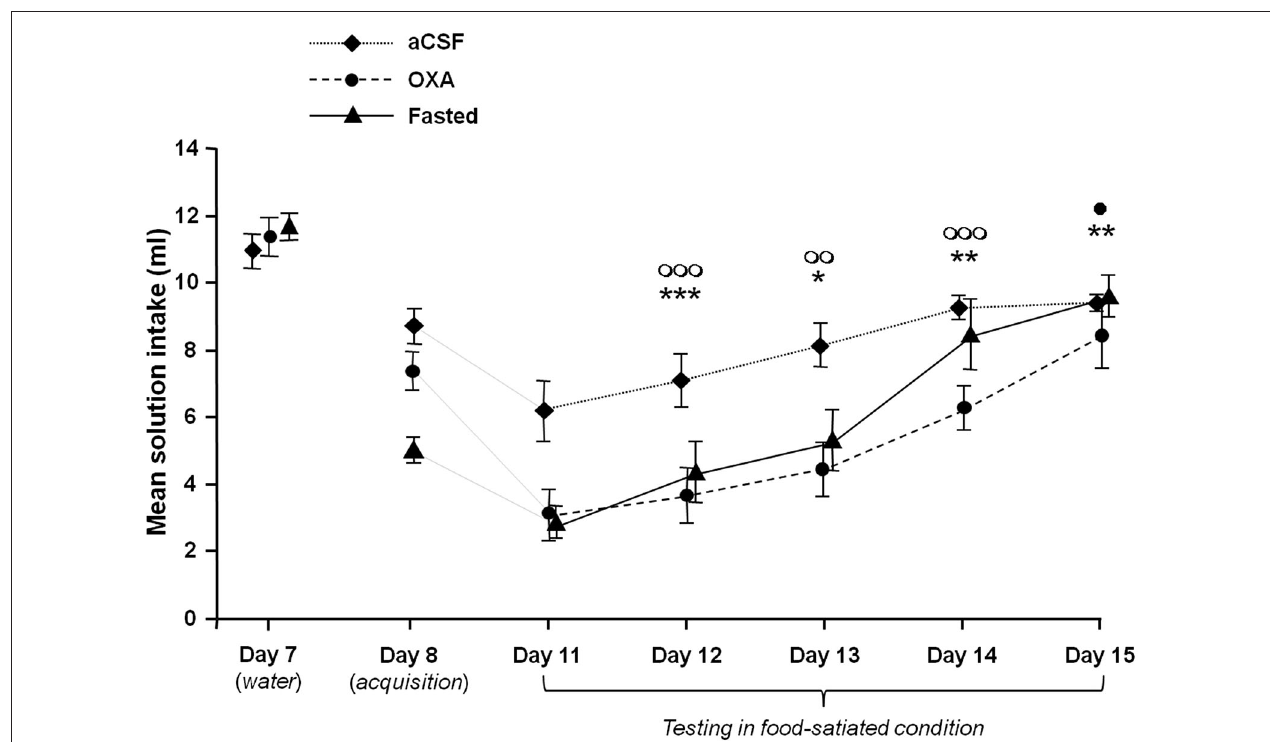
7) is also represented for each group for purposes of comparison. The Fasted group was food-deprived only during acquisition. All animals were habituated and tested while food satiated. *, ** and ***: P < 0.05, P < 0.01 and p < 0.001 between OXA and aCSF group. (cid:13)(cid:13) and (cid:13) (cid:13) (cid:13) P < 0.01 and